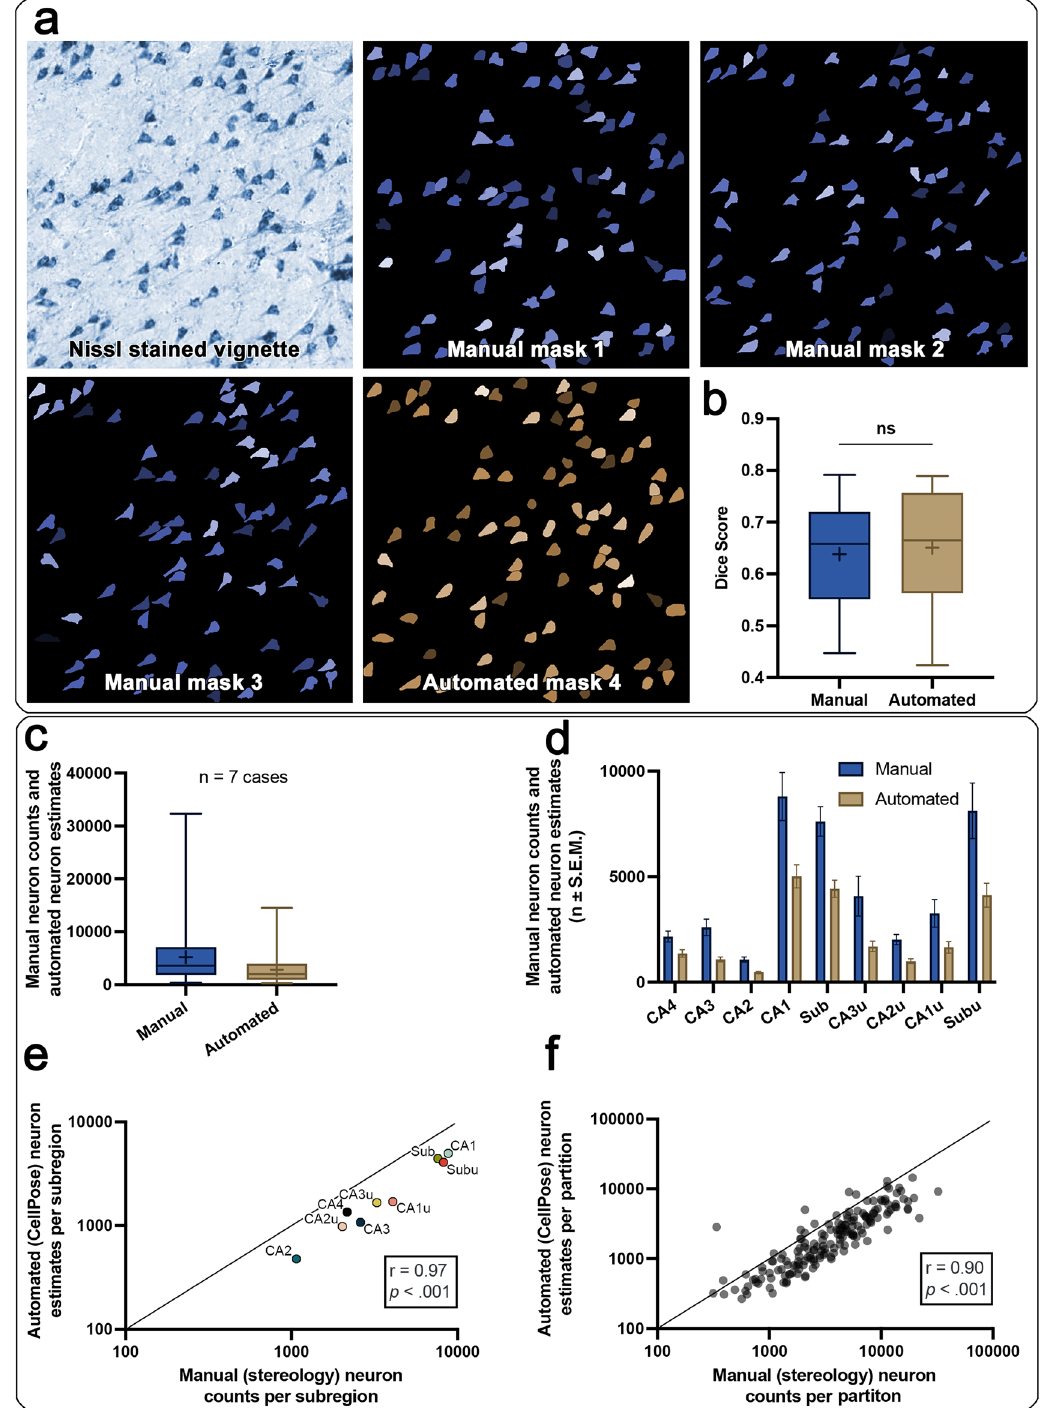
Figure 4. Correlation of the CellPose deep learning pipeline: ( a ) Nissl stained vignette used for pyramidal neuron segmentation, three raters performed manual segmentations (masks 1, 2, 3; blue), and CellPose performed the automated segmentation (mask 4; brown). ( b ) No significant difference between the Dice scores calculated from the manual masks (manual rater versus manual rater), and automated masks (automated versus manual rater). Whiskers indicate min to max, + indicates mean, line indicates median. ( c ) Manual pyramidal neuron counts and automated pyramidal neuron estimates. Averaged across subregions, levels and cases. Whiskers indicate min to max, + indicates mean, line indicates median. ( d ) Subregion specific pyramidal layer neuron estimates, averaged across cases and levels. ( e ) Excellent correlation of manual (stereology) and automated (CellPose) pyramidal layer neuron estimates averaged per subregion (Spearman’s correlation (n = 9): r(7) = 0.97, p < 0.001). ( f ) Excellent correlation of manual (stereology) and automated (CellPose) pyramidal layer neuron estimates per partition (not averaged per subregion; Spearman’s correlation (n = 168): r(166) = 0.90, p <